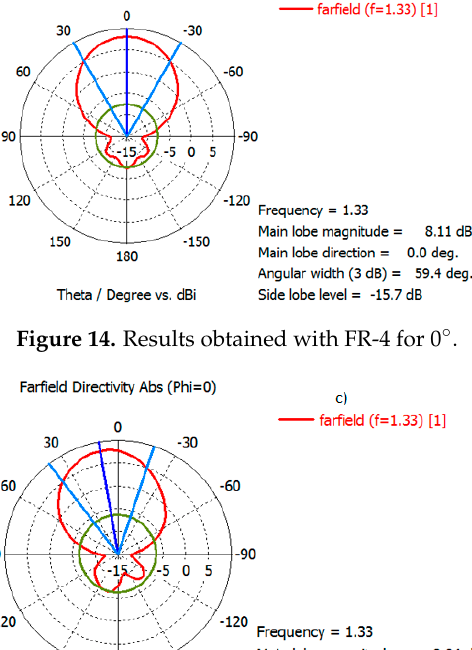
Figure 13. Results obtained with FR-4 for − 5°.